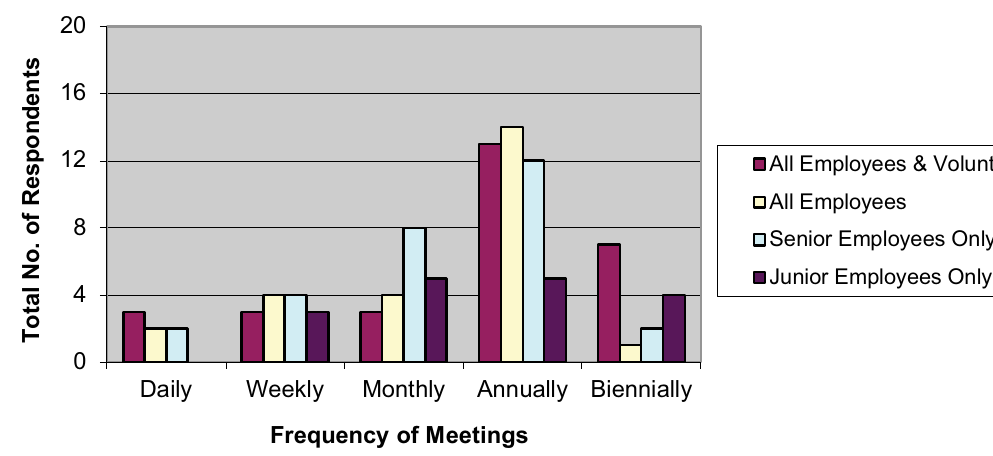
Figure 8. Reported frequency of general meetings in reintroduction